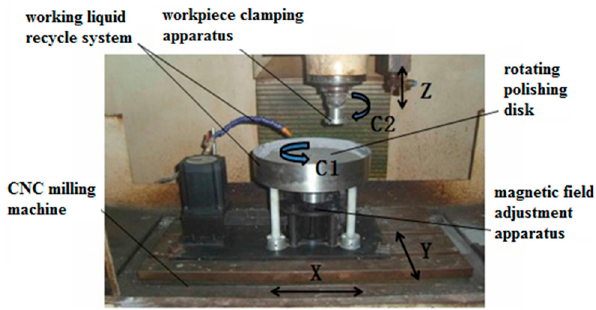
Figure 2. Experimental apparatus for cluster MR effect in plane polishing.